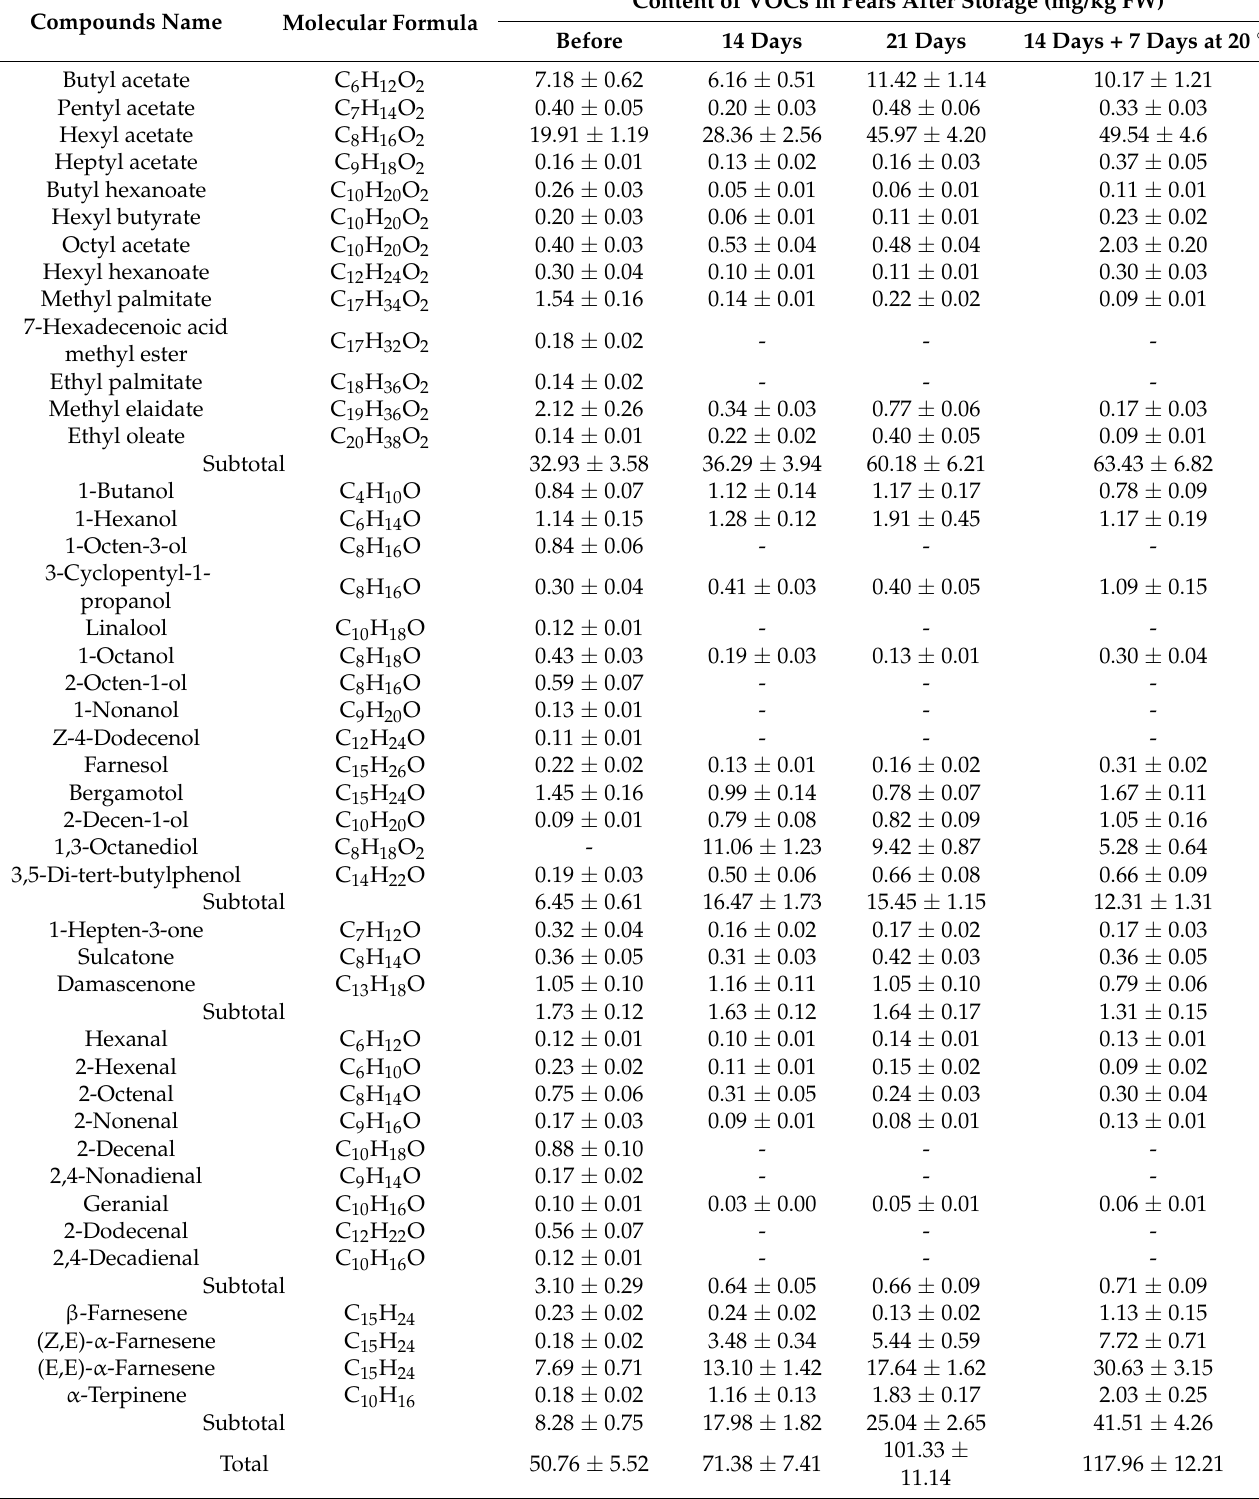
Table 2. Contents of VOCs in Dr. Guyot pears during storage at 4 ◦